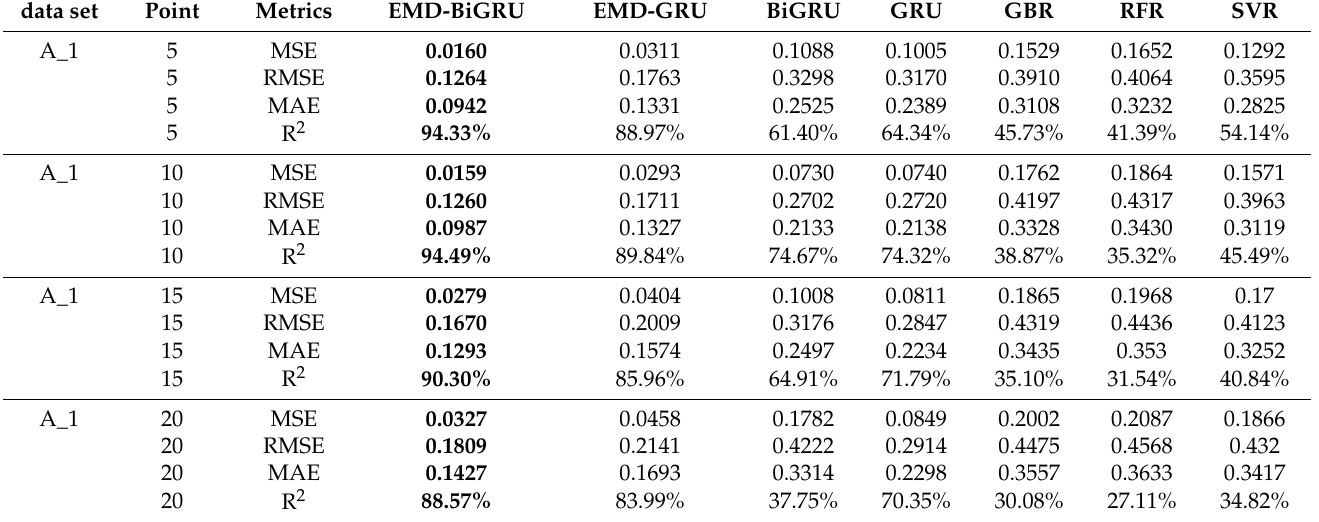
Table 3. Comparison results of different models for data set A_1.